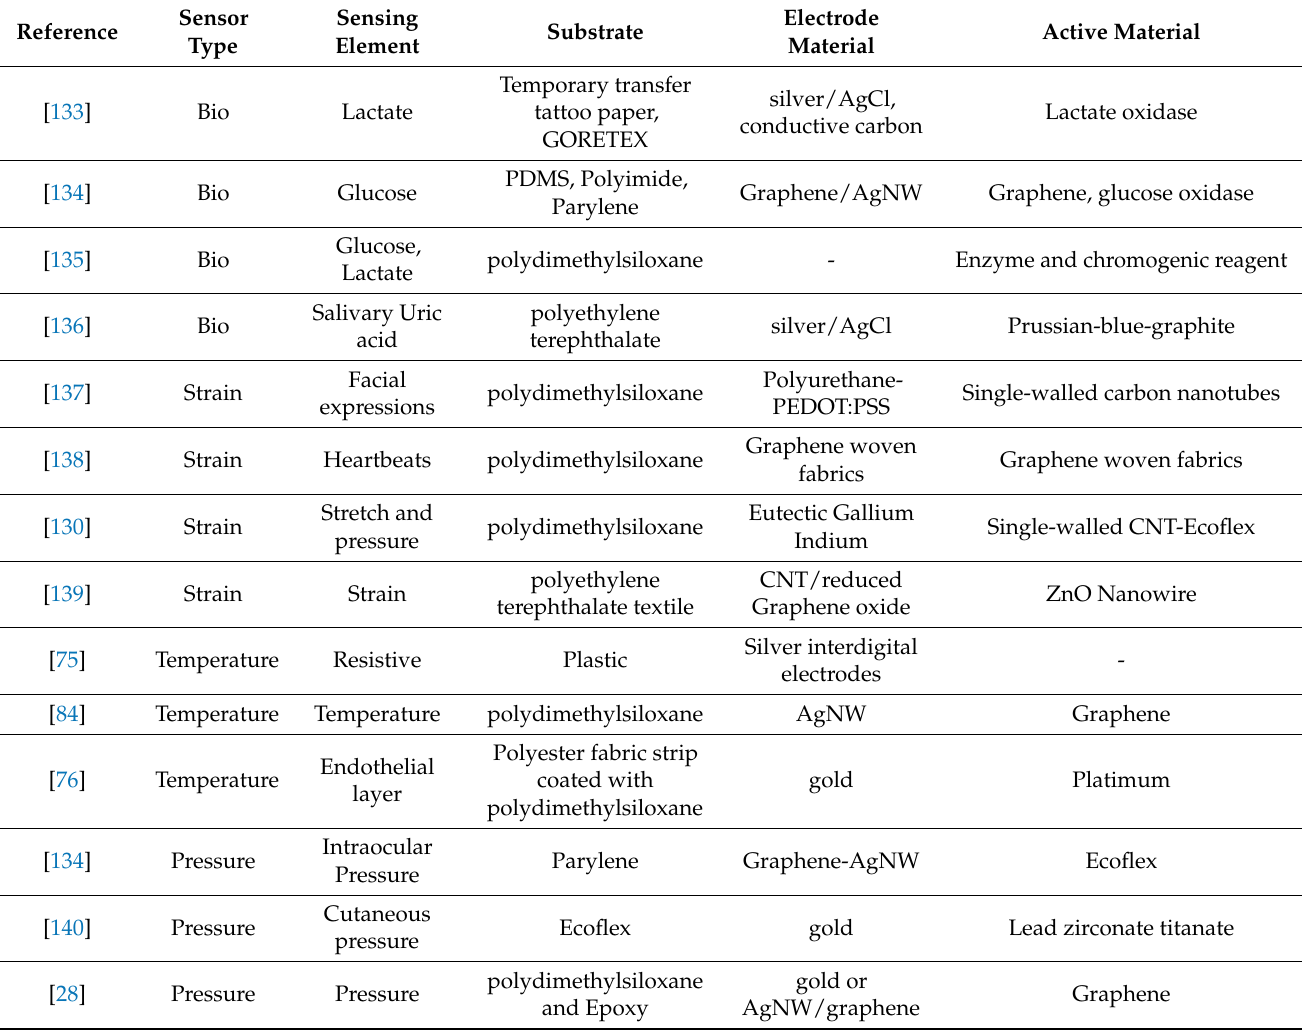
Table 3. Summary of wearable electronic sensing instruments for different